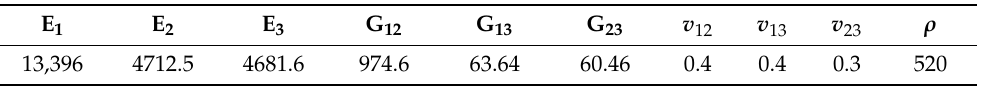
Table 3. Material Properties of CLT used in the calibrated FE model. Stiffness parameters have the unit of MPa and the density is given in kg/m 3 .